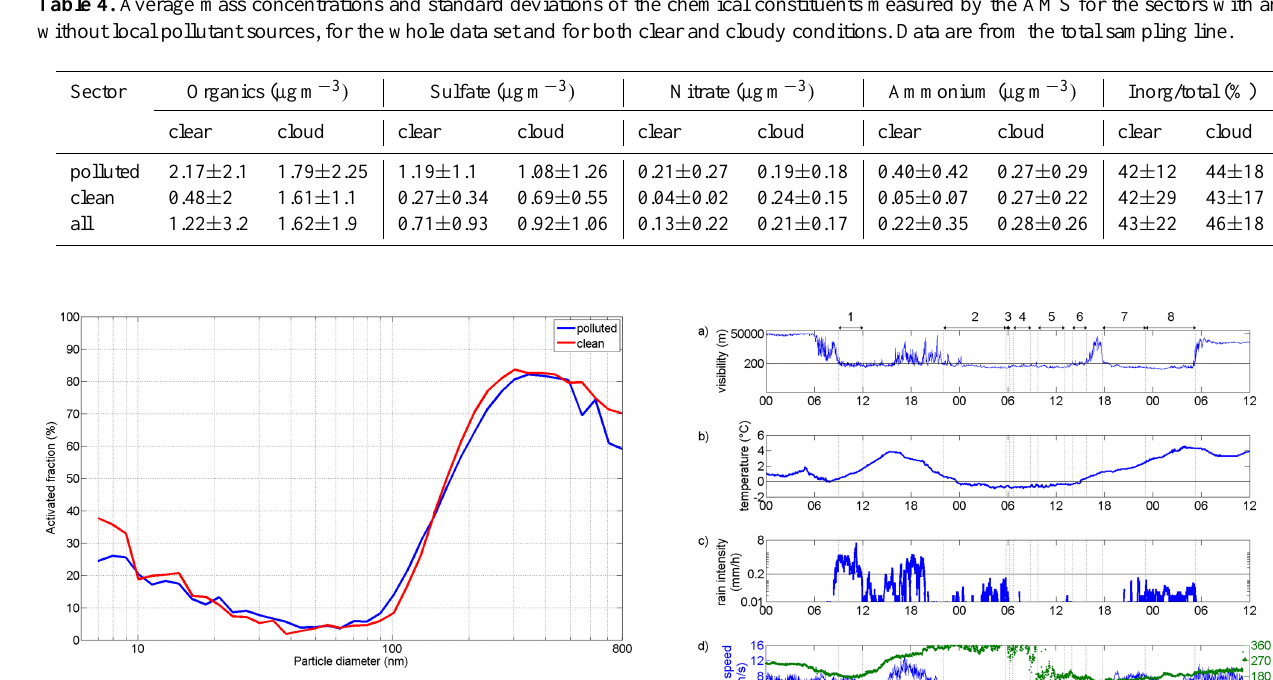
Figure 3. Average activated fractions as a function of particle diam- eter for polluted and clean sectors.